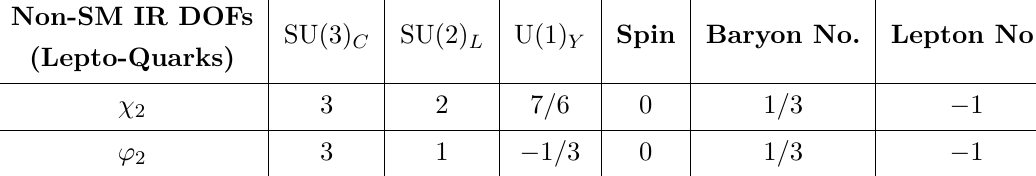
Table 34 . Additional IR DOFs (Lepto-Quarks) as representations of the SM gauge groups along with their spin, baryon and lepton numbers.